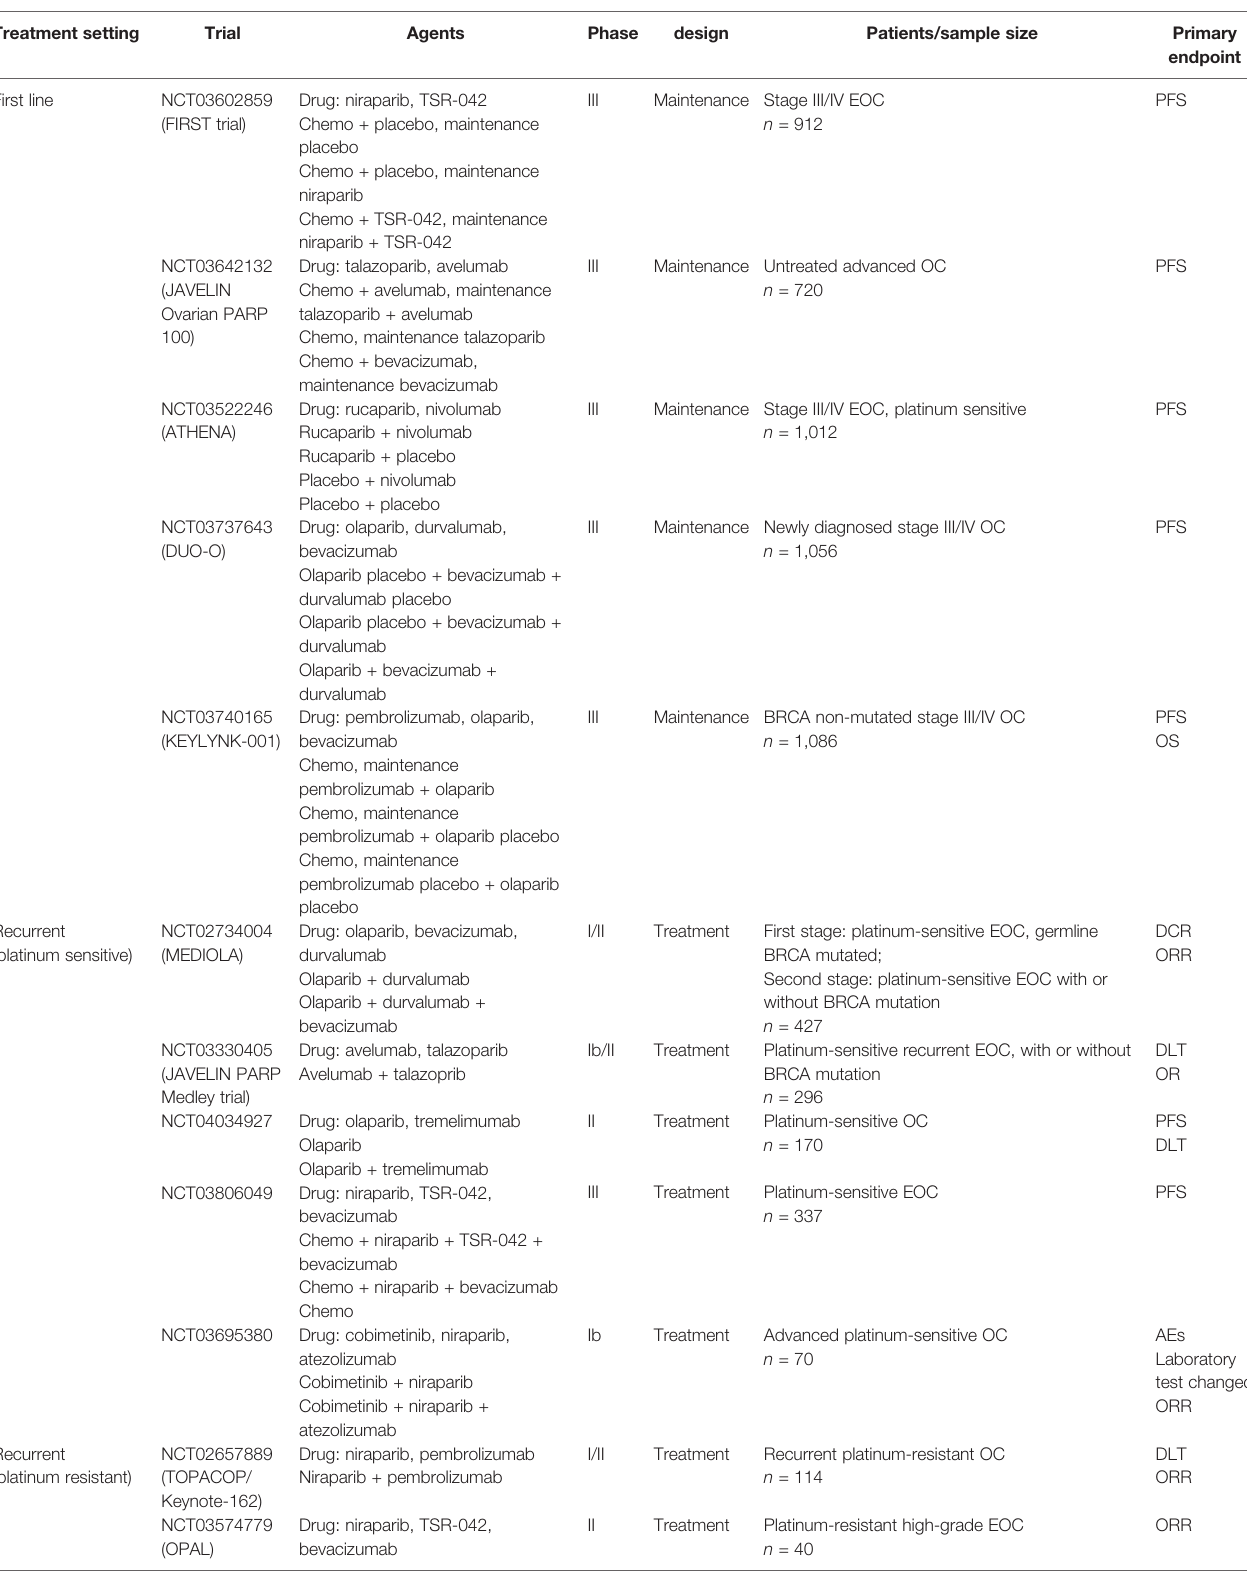
TABLE 1 | Clinical trials using poly (ADP ribose) polymerase (PARP) inhibitor and immunotherapy in ovarian cancer. Treatment